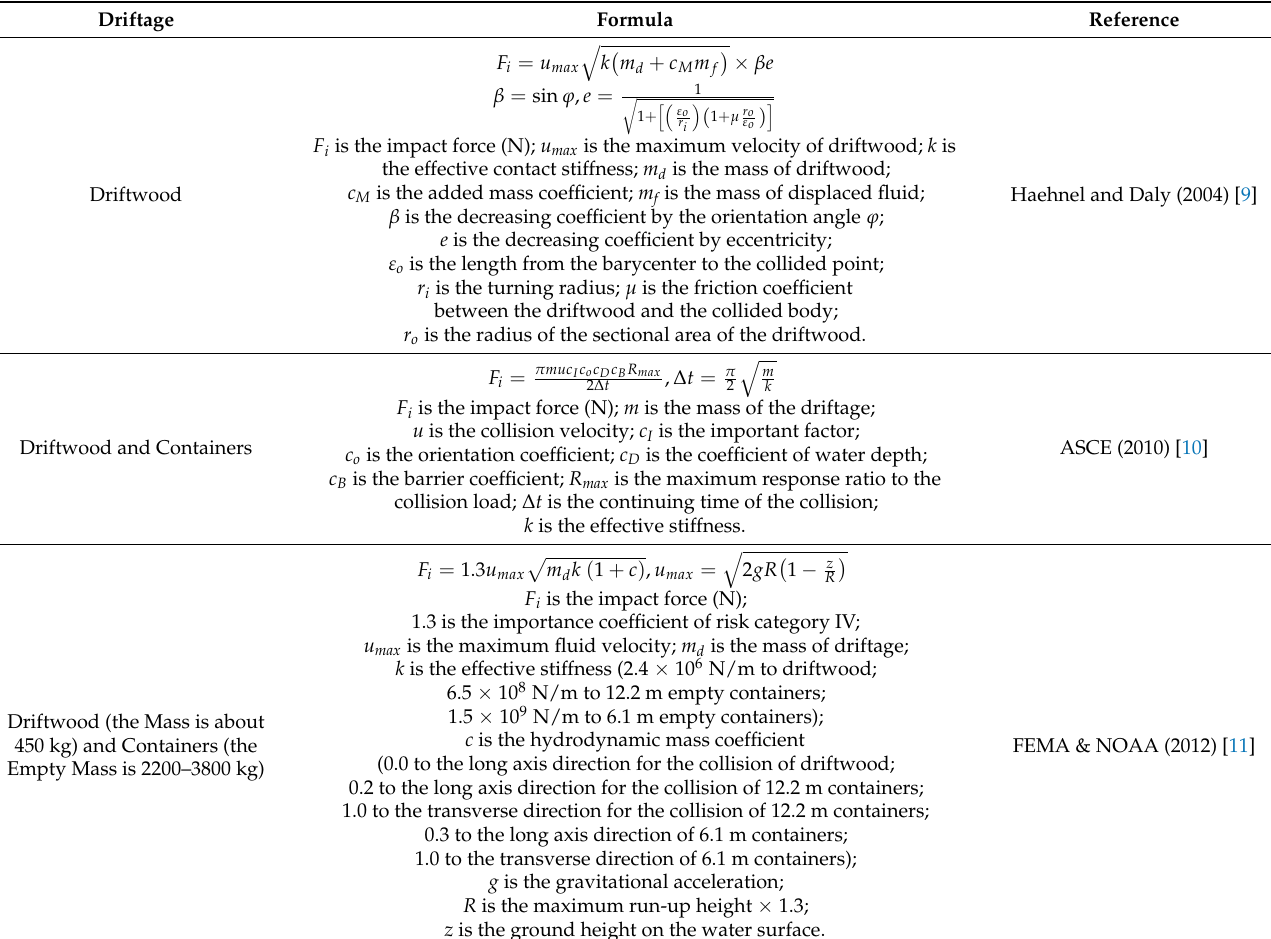
Table 1. Impact force formula (no.